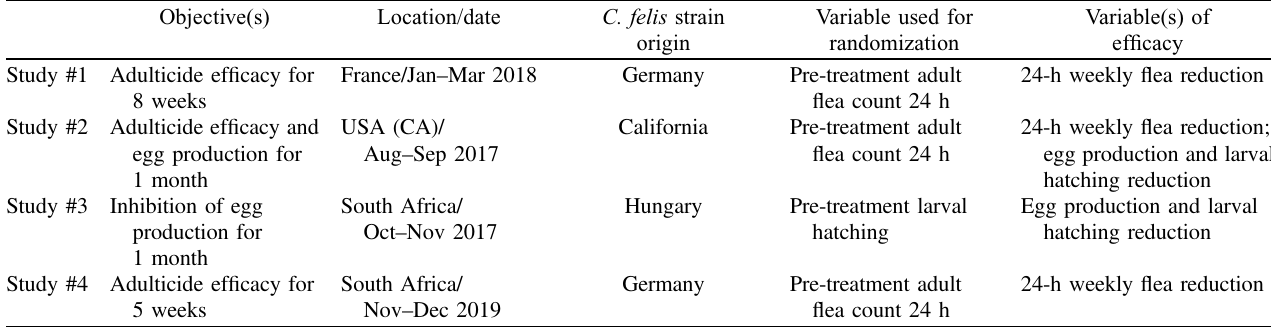
Table 1. Study objectives and